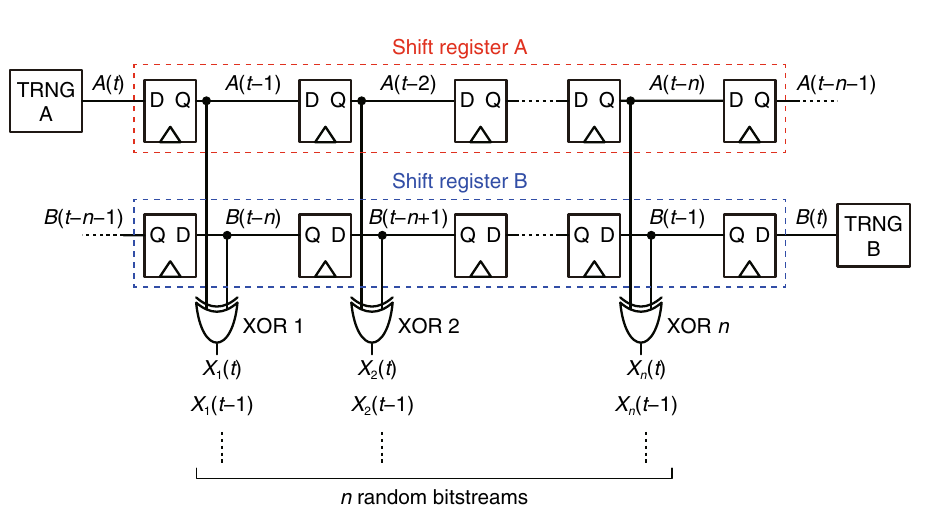
Figure 2. XSR. The two shift registers and n XOR gates generate n uncorrelated random bitstreams from the two uncorrelated random bitstreams generated by the two